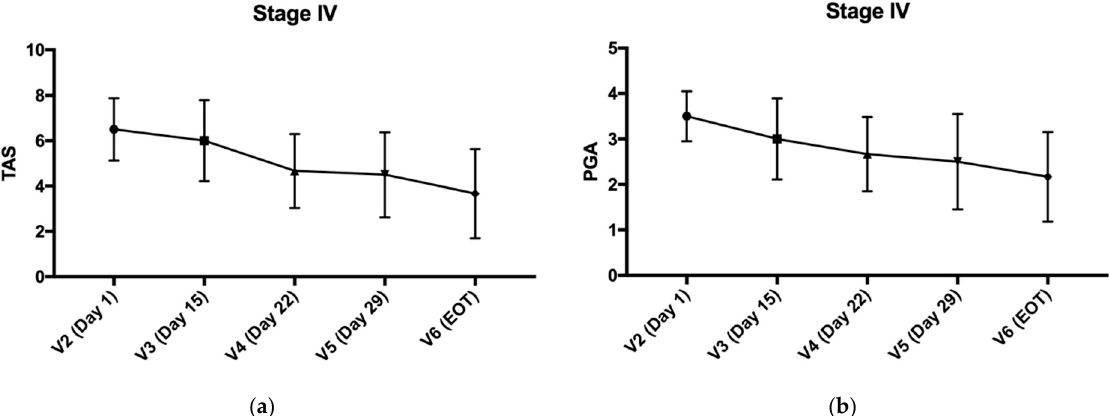
Figure 2. ( a ) The TAS scores of the target lesions in the single-arm KX01 1% group in stage IV. ( b ) The PGA scores of the target lesions in the single-arm KX01 1% group in stage IV.